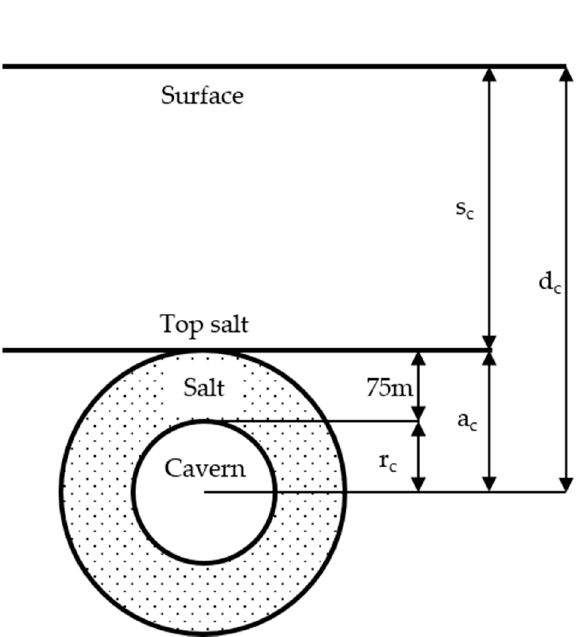
Figure 3. Sketch of the geometric arrangement of a cavern as used for modelling ( d c depth of cavern center, s c top salt, a c radius of salt sphere, r c cavern radius) .